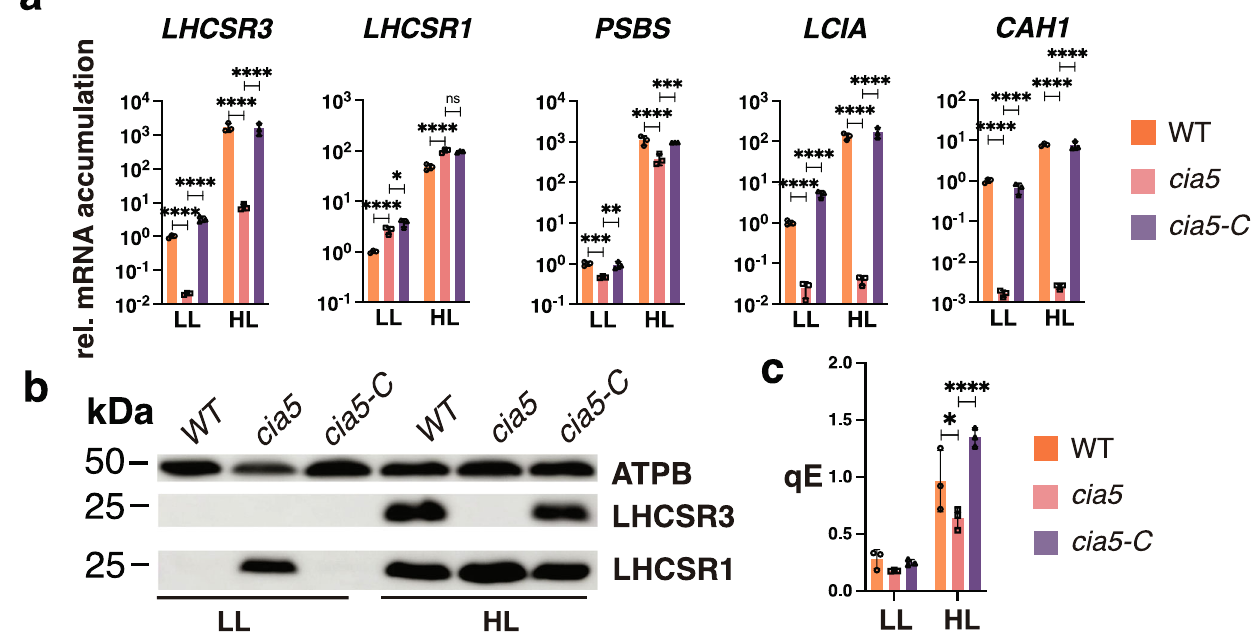
Fig. 3 | Cross-talk of responses to HL and low-CO 2 . a CC-125 WT, cia5 and cia5 -c strainswereacclimatedfor16hinLL(15 µ molphotonsm − 2 s − 1 )inHSMbubbledwith air (labelled as “ LL ” ); after sampling for the LL conditions, light intensity was increasedto600 µ molphotonsm − 2 s − 1 (HL);samplesweretakenafter1h(RNA)and 4h (protein and photosynthesis measurements). Accumulation of mRNA of genes attheindicatedconditionswerenormalizedtoWTLLctrl.( n =3biologicalsamples, mean± s.d.).Thep-valuesforthecomparisonsofWTwith cia5 and cia5 with cia5-C are based on ANOVA Dunnett ’ s multiple comparisons test of log10 transformed